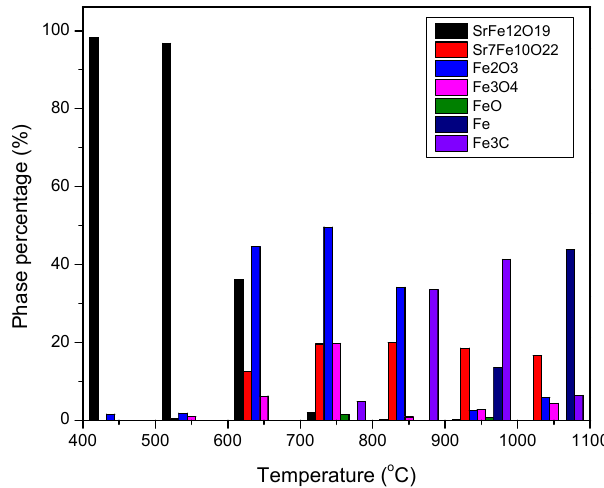
Figure 5. Phase percentage of different phases in the samples obtained by CH 4 heat treatment at different temperatures.